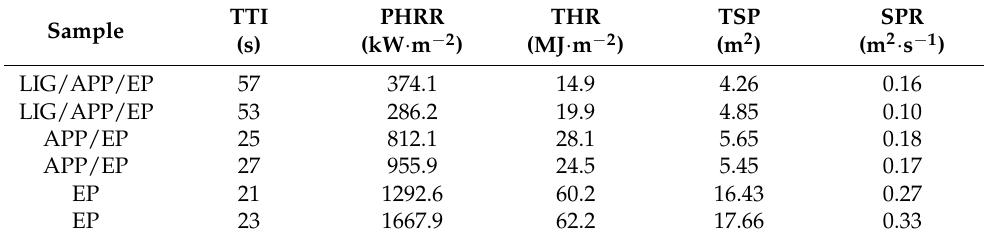
Figure 4. The results of the cone test. ( a ) Heat release rate (HRR), ( b ) total heat release (THR), and ( c ) total smoke production (TSP) curves of the EP, APP/EP, and LIG/APP/EP. Digital photo images of the residual carbon from the cone tests of the ( d ) EP, ( e ) APP/EP, and ( f ) LIG/APP/EP. Table 1. Combustion data of the neat EP, the APP/EP, and the